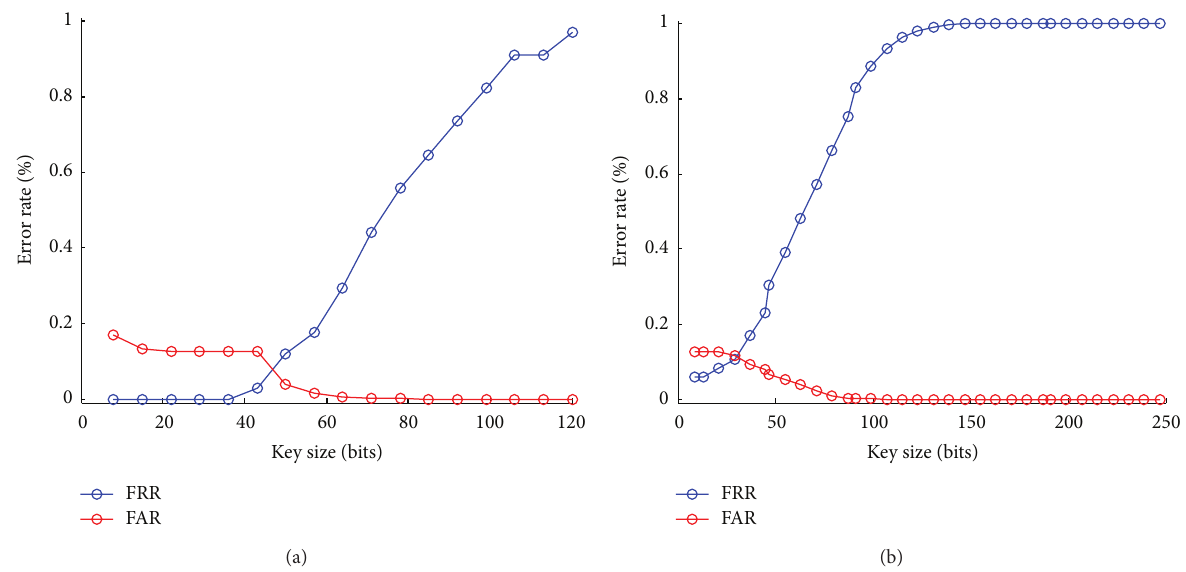
Figure 6: The error rates of FAR and FRR of the key binding result in terms of codeword lengths of 127 (a) and 255 (b).